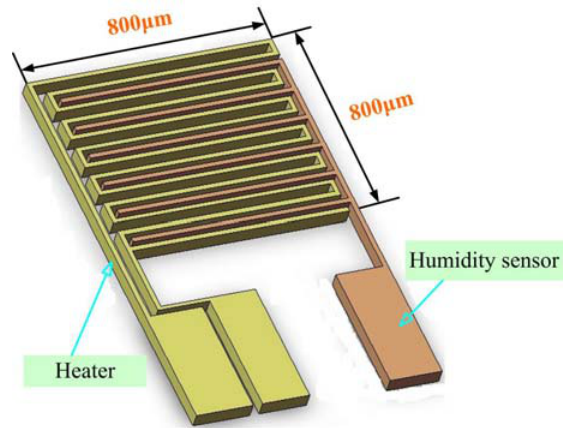
Figure 3. Design of the micro humidity